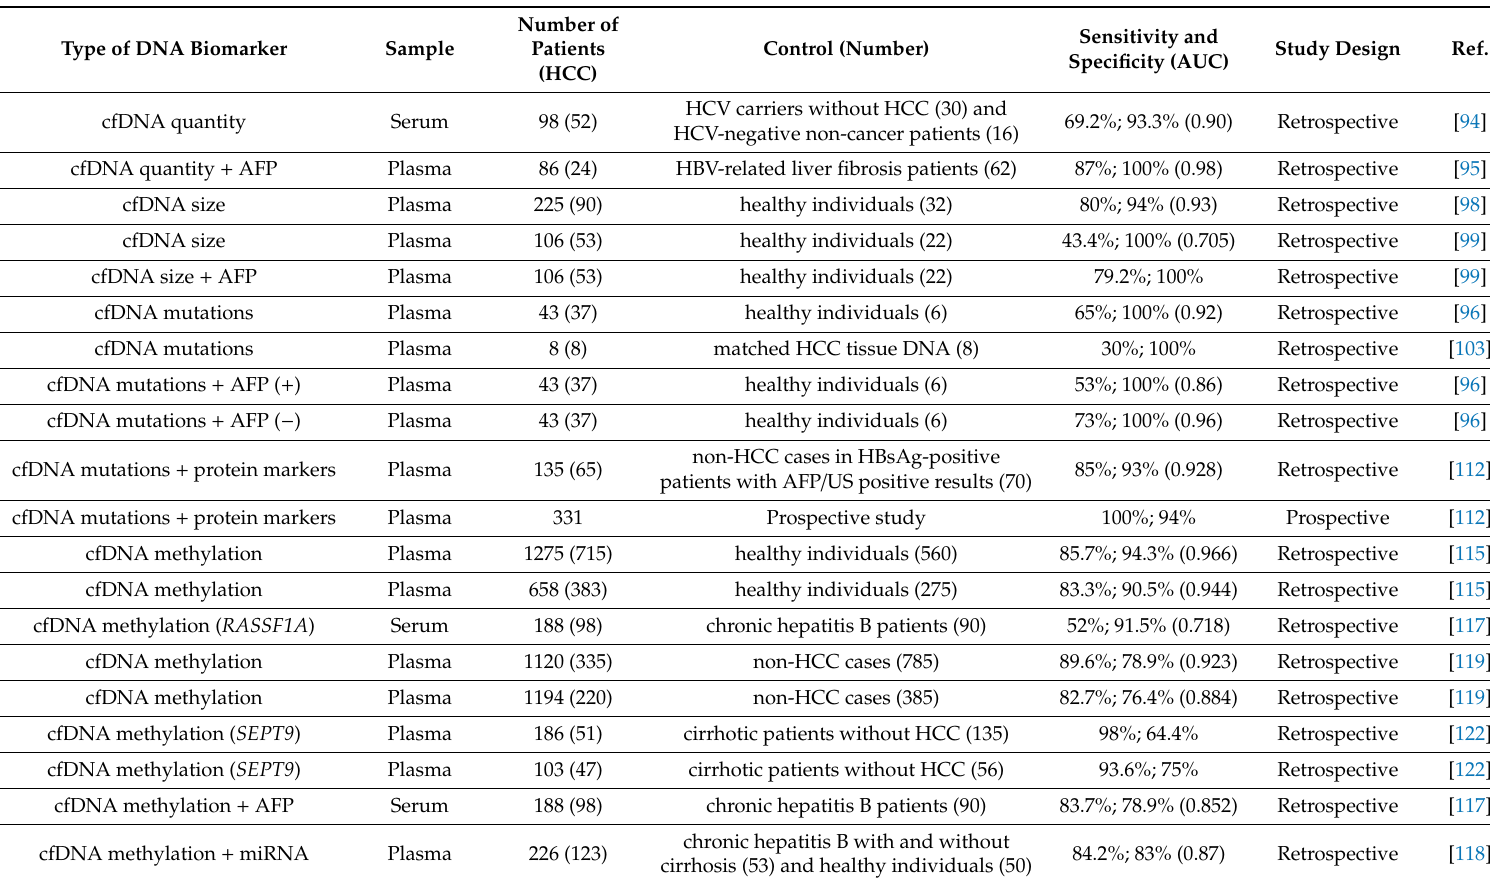
Table 2. HCC: hepatocellular carcinoma, AUC: area under the curve, cfDNA: “cell-free DNA”, HCV: hepatitis C virus, AFP: alpha-fetoprotein, HBV Hepatitis B, HBsAg: surface antigen of hepatitis B virus, US: ultrasonography, RASSF1A : RAS association domain family protein 1A, SEPT9 , Septin 9